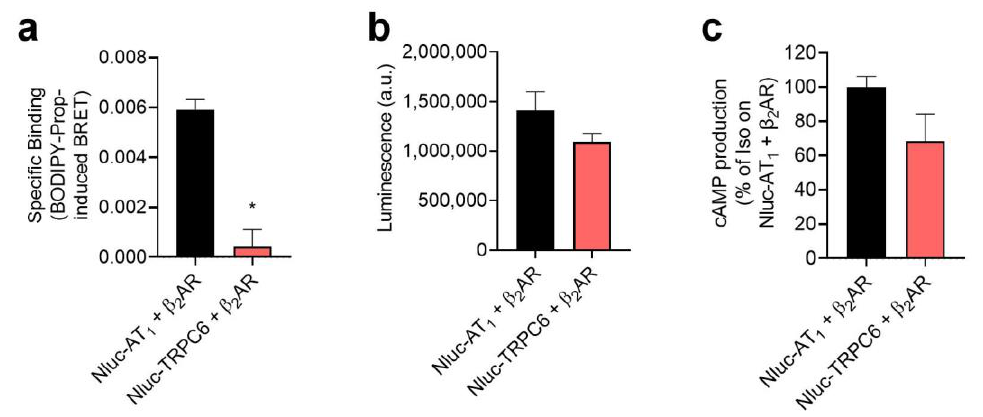
Figure 6. Lack of Receptor-Heteromer Investigation Technology (Receptor-HIT) signal with β 2 AR and TRPC6. Cells were transfected with Nluc-AT 1 + β 2 AR or Nluc-TRPC6 + β 2 AR. In the BRET ligand binding assay ( a ), cells were treated with 80 nM BODIPY-propranolol in the presence or absence of 10 µ M propranolol to enable calculation of BODIPY-propranolol specific binding. In the luminescence assay ( b ), raw luminescence values were obtained from untreated aliquots of cells. In the cAMP assay ( c ), cells were treated with 10 µ M isoprenaline (Iso). Significant differences (*) were observed in ( a ) but not ( b , c ), using unpaired t -tests. Data are displayed as mean ± SEM of three independent experiments.